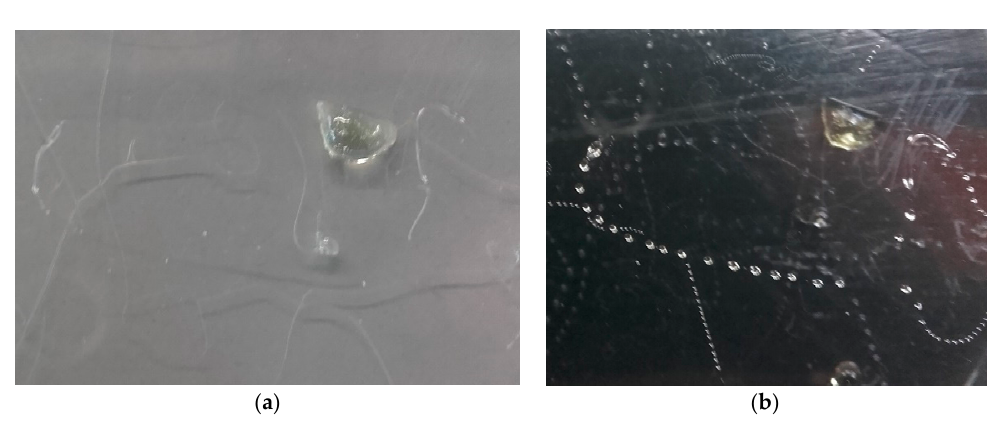
Figure A2. Viscosity determined via continuous shear experiments and the shear rate dependency at 90 °C for both sugar glass and carbohydrate glass.